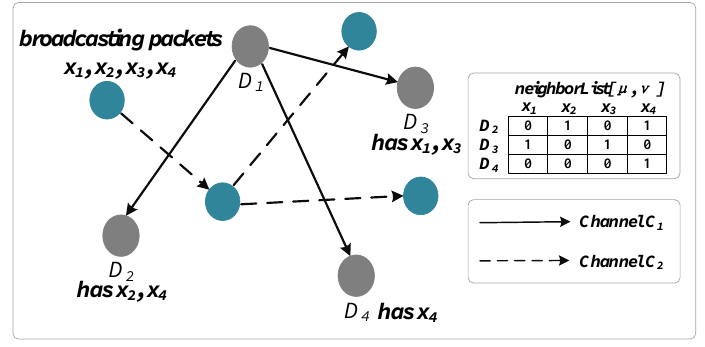
Figure 3. Example with a broadcast source and three receiver sensor